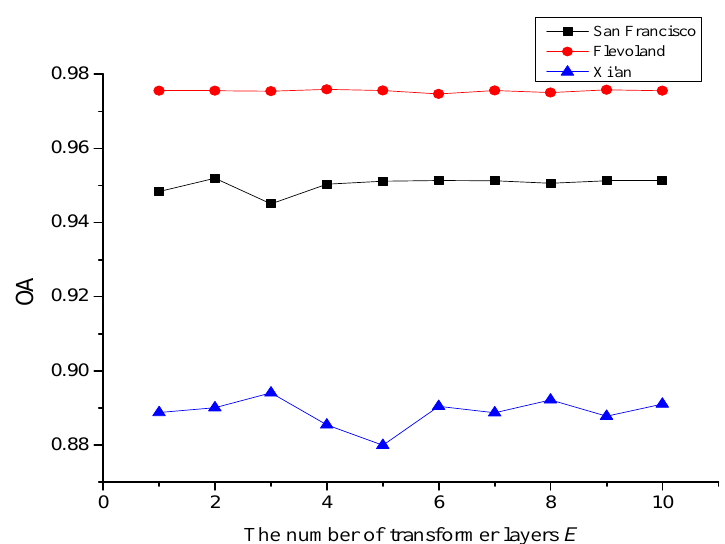
Figure 13. Influence of the number of transformer layers in the